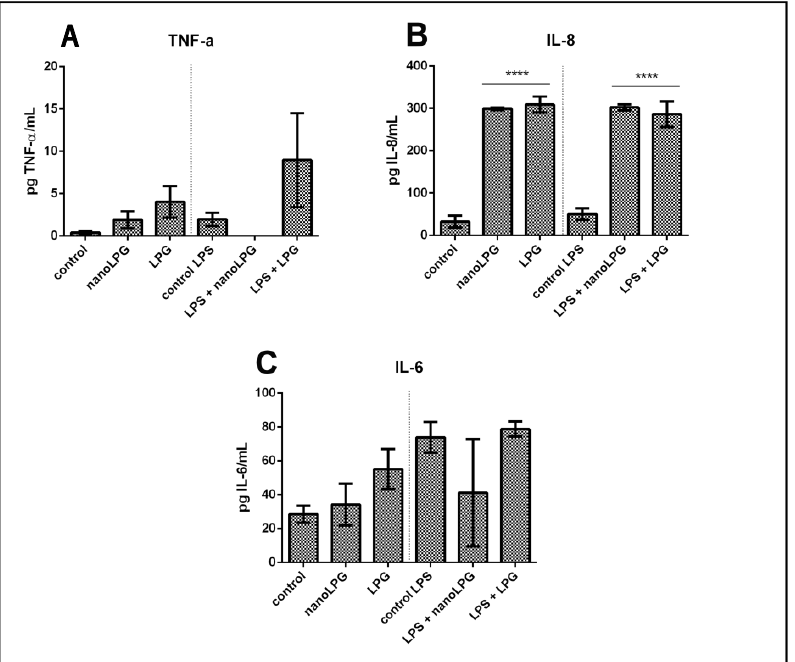
Figure 3. Action of free LPG and nanoLPG on the production of TNF- α ( A ), IL-6 ( B ) and IL-8 ( C ) in HaCaT cells. The left part of all graphs corresponds to the non-stimulated cell response, and the right is related to the anti-inflammatory effect. The production of TNF- α , IL-6 and IL-8 was determined by ELISA. The data represent the mean ± SD of one independent experiment in duplicate. **** p < 0.0001. Treatment compared to control and control LPS.